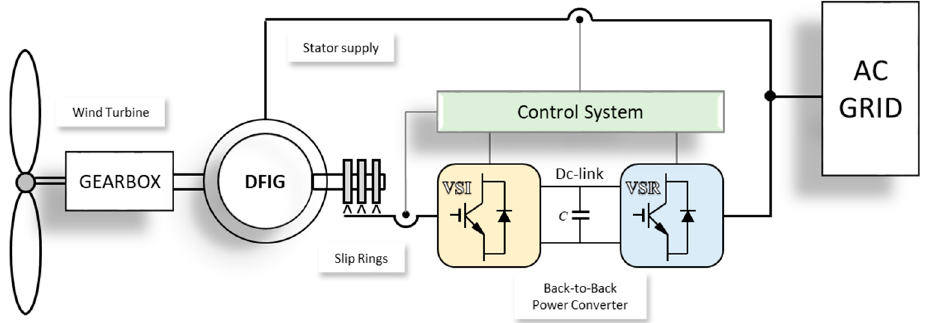
Figure 1. System block scheme.